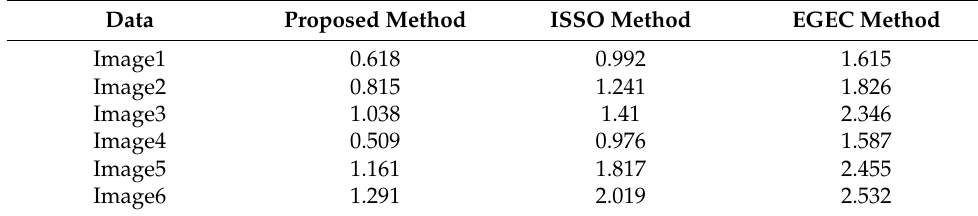
Table 3. The mean epipolar geometric distance of real images (pixel).